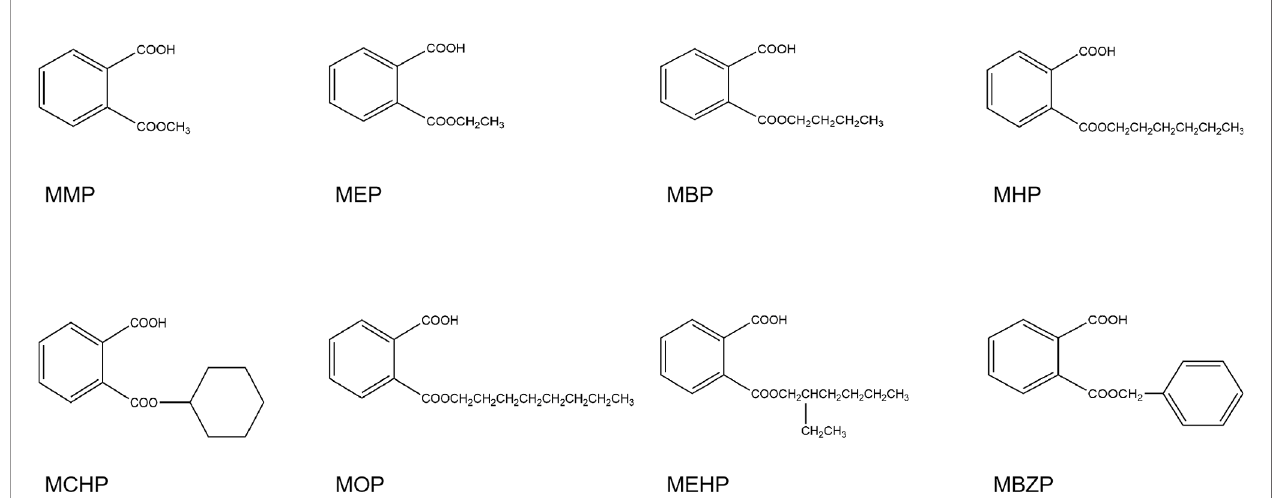
FIGURE 1 | The structure of eight phthalate